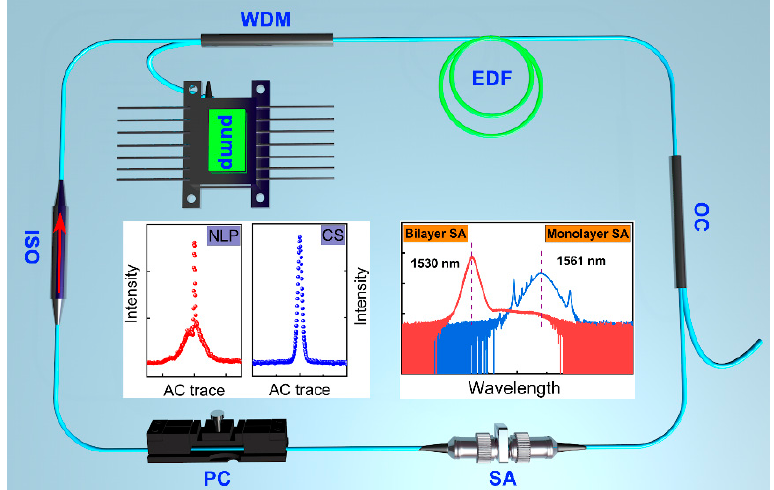
Figure 1. Schematic diagram of the mode-locked fiber laser based on polymer CNT-SA. Inserted left, the autocorrelation traces of CS with ML CNT-SA and NLP with BL CNT-SA. Inserted right, the corresponding CS and NLP spectra.